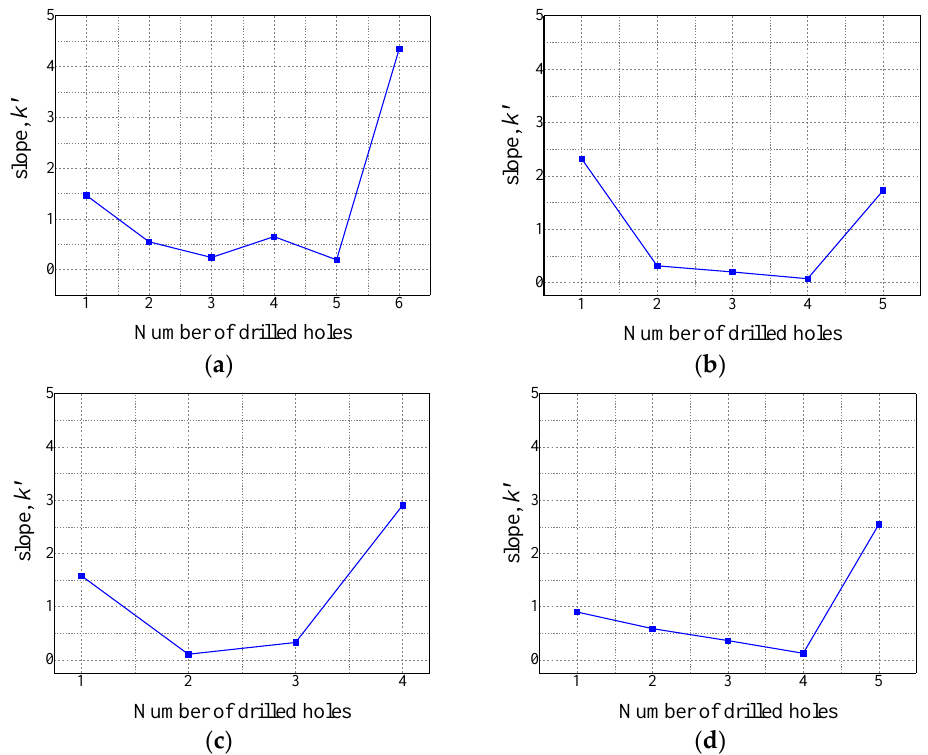
Figure 9. Slope between points A ’ and B ’ , k ’ (i.e., the slope k in Figure 8): ( a ) experiment condition 1, ( b ) experiment condition 2, ( c ) experiment condition 3, ( d ) experiment condition 4.